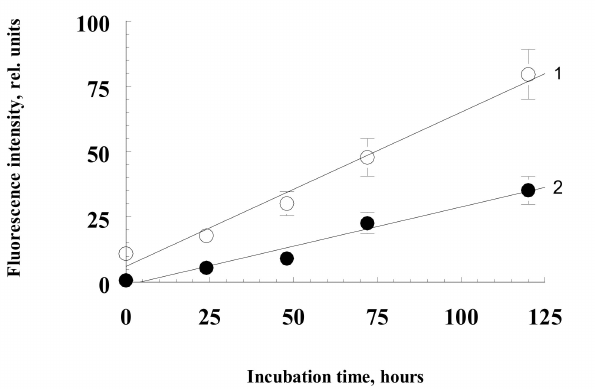
Figure 3. Kinetics of an increase in BSA fluorescence in the presence of water-soluble fractions obtained from irradiated (curve 1) and non-irradiated (curve 2) bisretinoid A2E.The reaction medium contained sterile 0.1 M K-phosphate buffer, pH 7.4, 2.0 mg/mL BSA, 3 mM sodium azide, and 0.7 mL of water-soluble fractions SUPA2E-M. Data are means (means ± SD) of four assays.